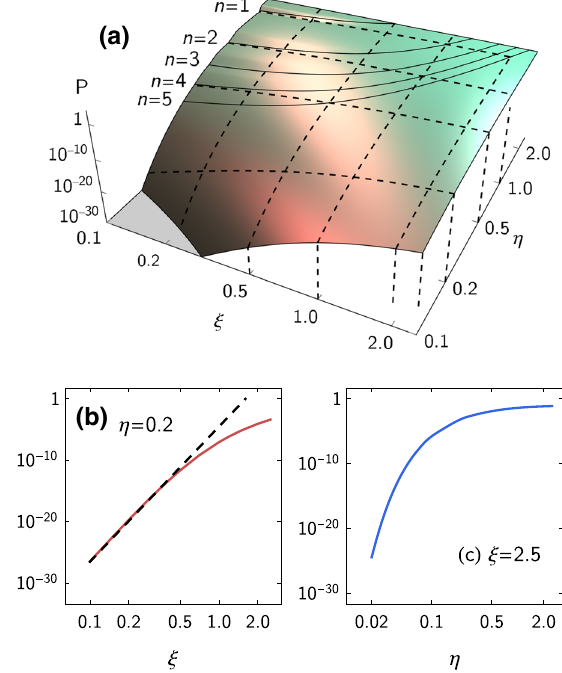
Fig. 1 Demonstrationofdifferentparameterregimesintheprobability of the nonlinear Breit–Wheeler process, P (ξ,η ; N ) , for a N = 16 cycle cos-squared pulse. The first five harmonic edges are drawn on the surface. Inset left: the multiphoton regime ( ξ (cid:8) 1), where at fixed η , P ∝ ξ 2 n (cid:7) , where n (cid:7) is the threshold harmonic (for η = 0 . 2, n (cid:7) = 11). Inset right: the tunneling regime ( ξ (cid:11) 1, χ (cid:8) 1), in which the probability is exponentially suppressed as P ∼ χ exp ( − 8 / 3 χ)